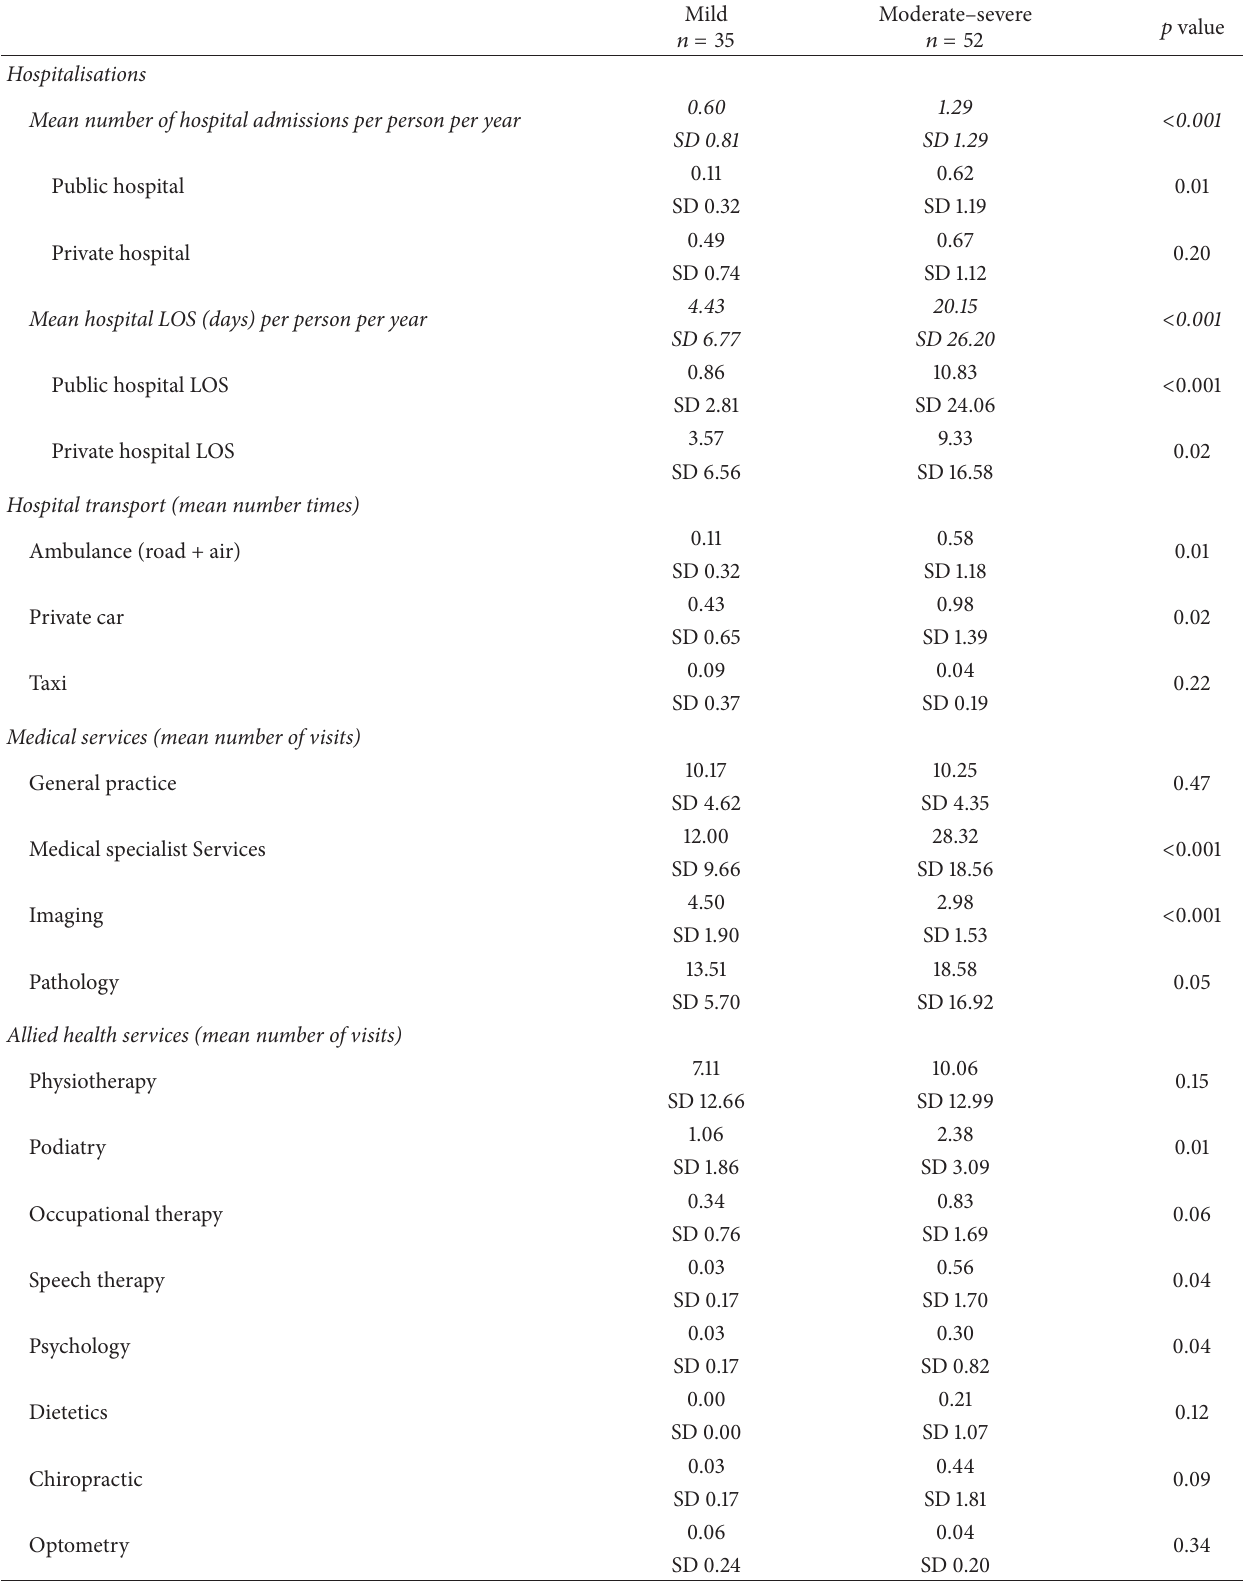
Table 4: Resource utilization related to Parkinson’s disease over 12